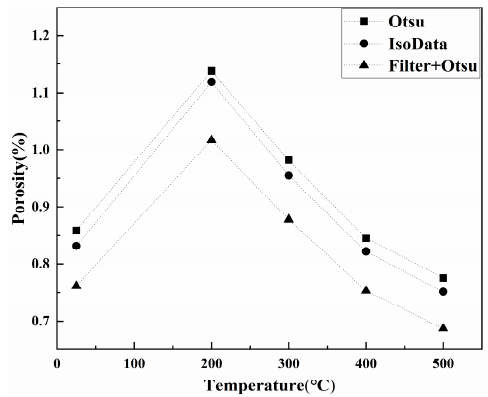
Figure 1. The evolution of porosity computed by three kinds of algorithms.